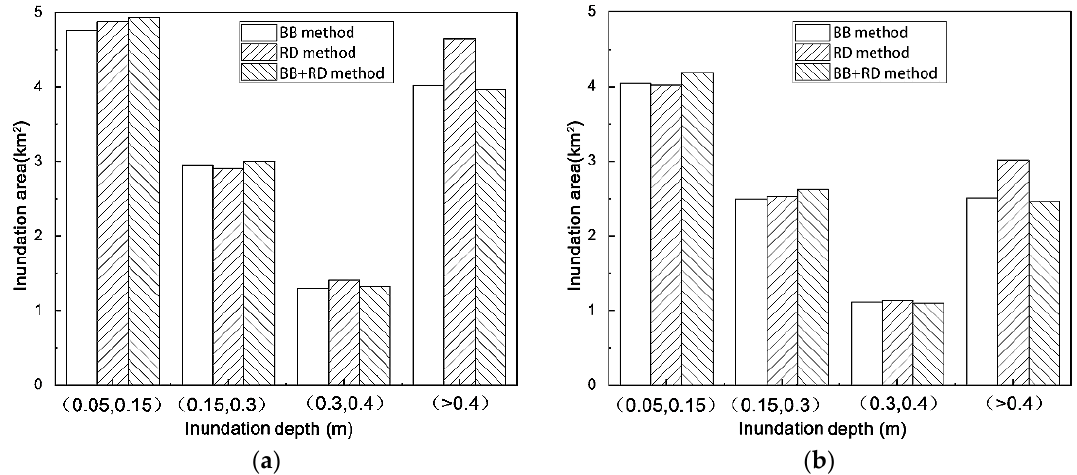
Figure 14. The inundation area as a function of inundation depth when using the BB, RD, and BB + RD methods: ( a ) 10-year return period; ( b ) 2-year return period.